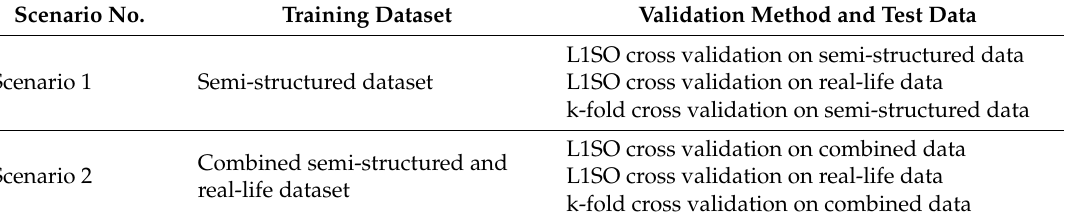
Table 3. Scenarios for separating data into a train and test data set and the corresponding validation